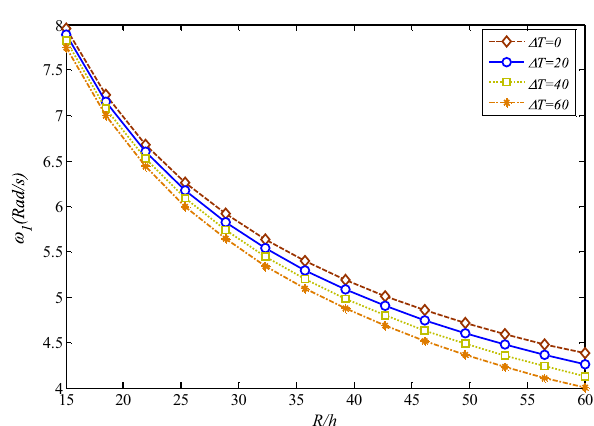
Figure 6: Temperature variations ’ e ff ect on the vibration of the shell ( h = 0.01 m , h